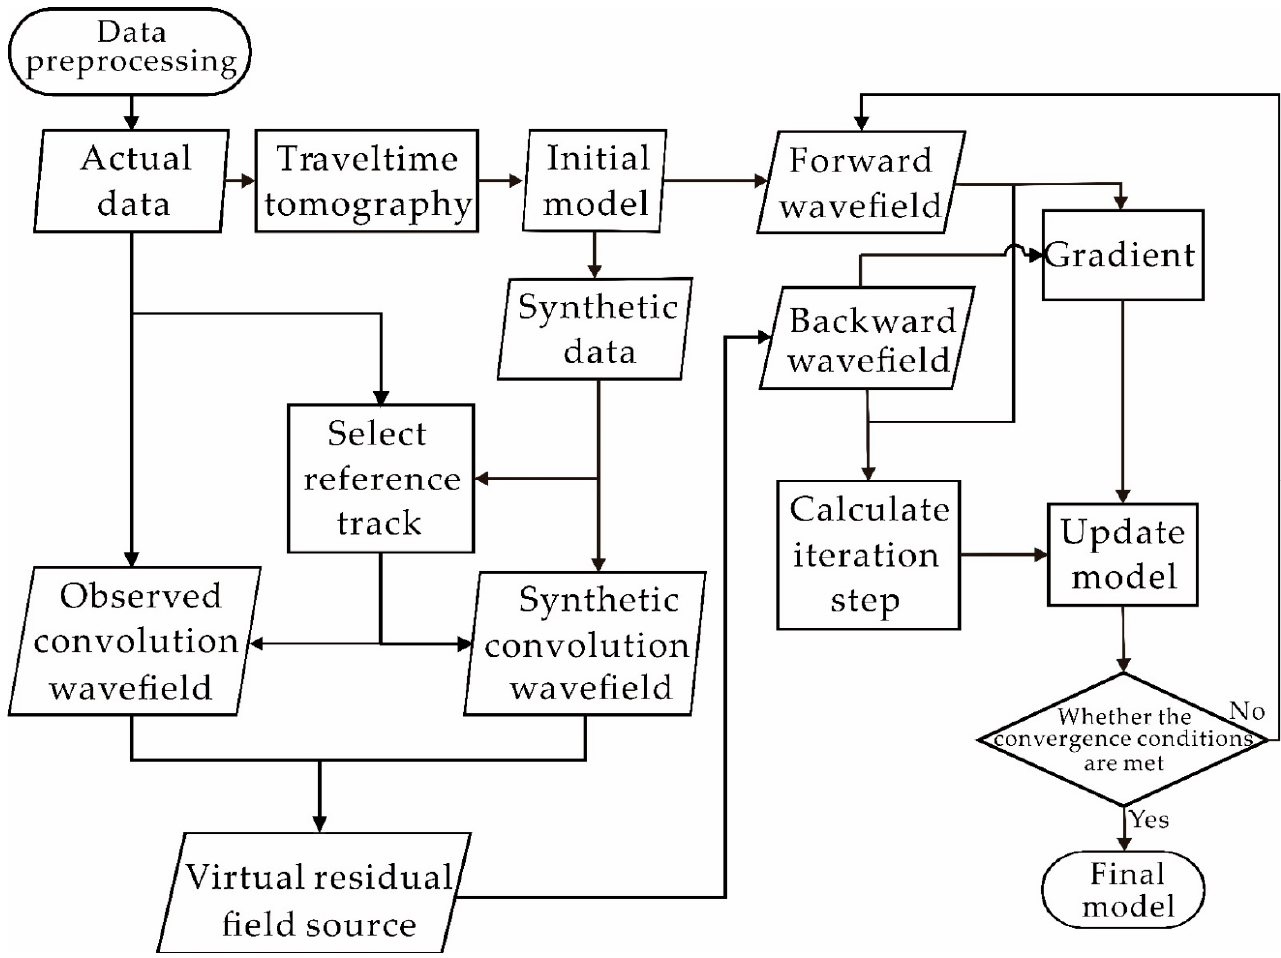
Figure 4. Source-independent wavelet waveform inversion strategy for real data.